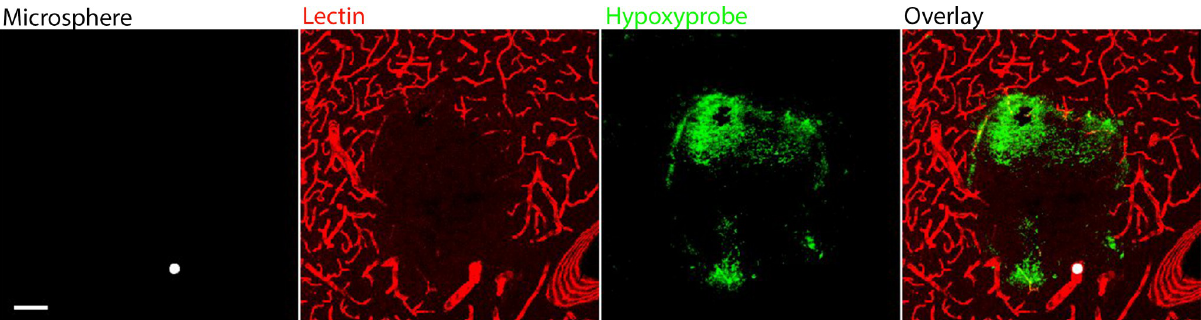
Fig 3. Maximum intensity projection (MIP) of a 50 μ m thick brain section of the intervention hemisphere showing a typical example of a 25 μ m (diameter) microsphere causing ischaemia (absence of lectin-red) and hypoxia (green) in the rat brain. Scale bar 100 μ m.